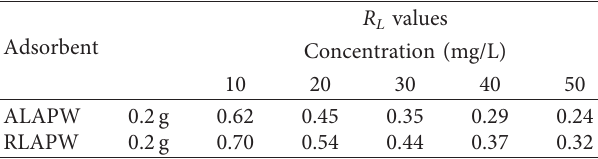
Table 5: R L (dimensionless constant separation factor) values at different initial